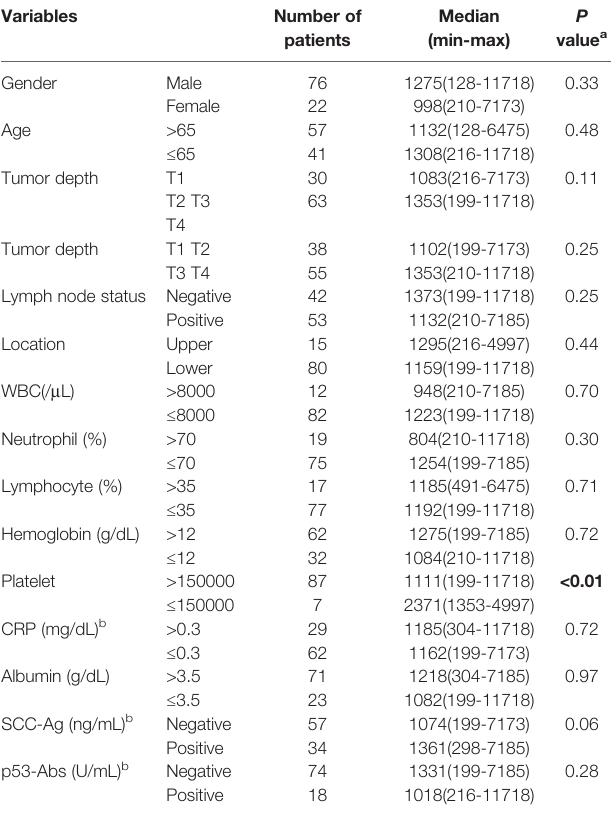
TABLE 7 | Comparison of serum BRAT1-Ab levels median according to clinicopathological characters of the patients with ESCC. Variables Number of